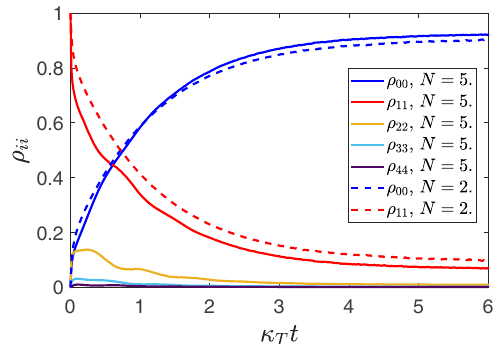
Fig. 1 Bath induced decay dynamics of a transmon. Decay dynamics of the diagonal elements of the reduced density matrix of a transmon with N states, starting from an occupied fi rst excited state ρ 11 ( t = 0) = 1. The data have been obtained using the SLED. We have used the parameters E J / E C = 100, κ / ω 01 = 0.2, β ℏ ω 01 = 5, ω c = 50 ω 01 , and κ T ¼ κ coth ð β _ ω 01 = 2 Þ